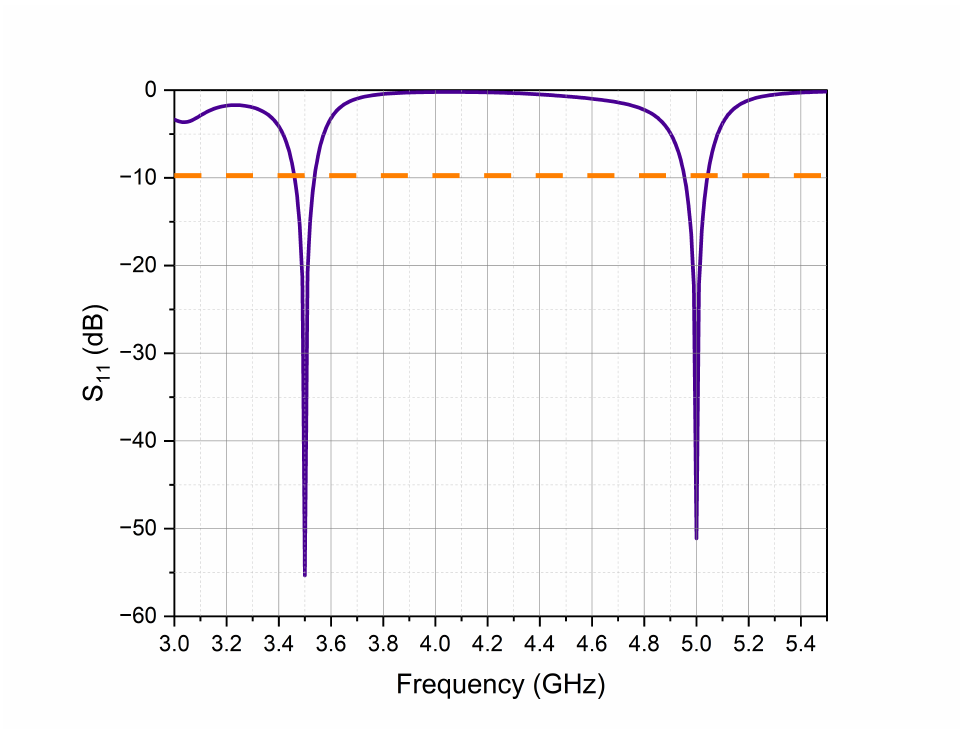
Figure 6. S 11 Reflection